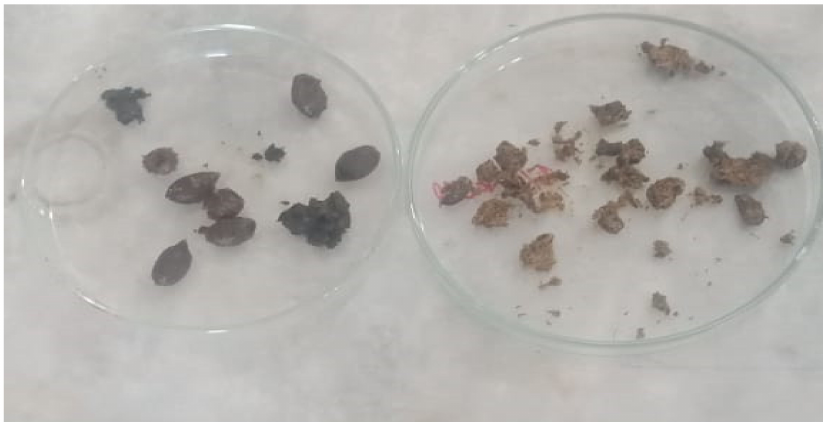
Figure 2. Fecal Samples of Sheep and Goats Containing Haemonchus contortus